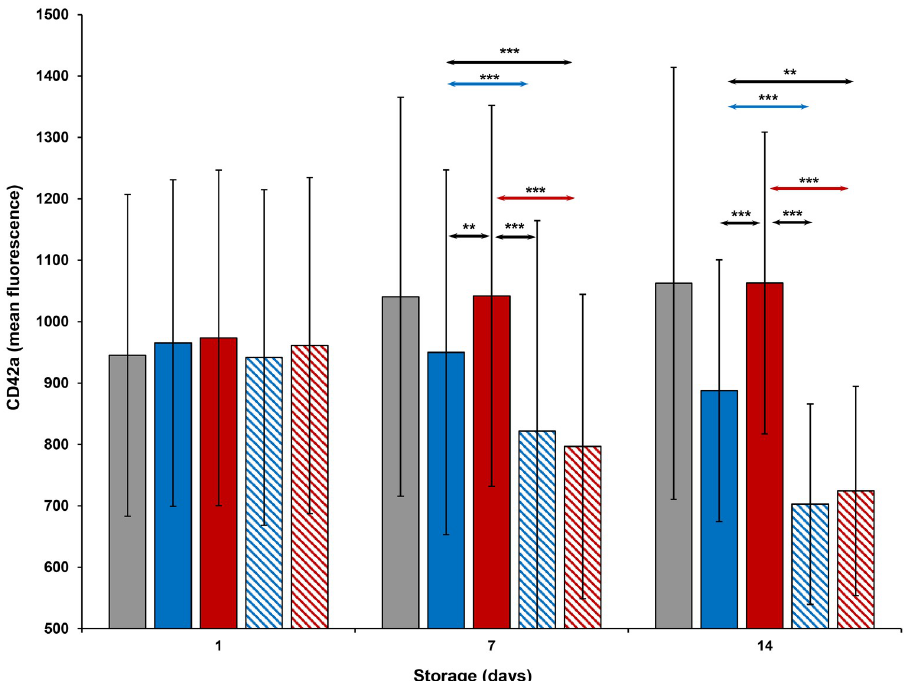
Fig 11. Effects of 14-day storage, temperature and presence of p38MAPK inhibitor on CD42a expression on platelets. Grey bar–platelets stored at room temperature; blue solid bar–cold-stored platelets; red solid bar– thermocycled-stored platelets; blue striped bar–cold-stored + VX-702 platelets; red striped bar–thermocycled-stored + VX-702 platelets. Data represents the mean of 15 experiments with one standard deviation. Arrows represent paired statistical differences; �� —p < 0.01, ��� —p <